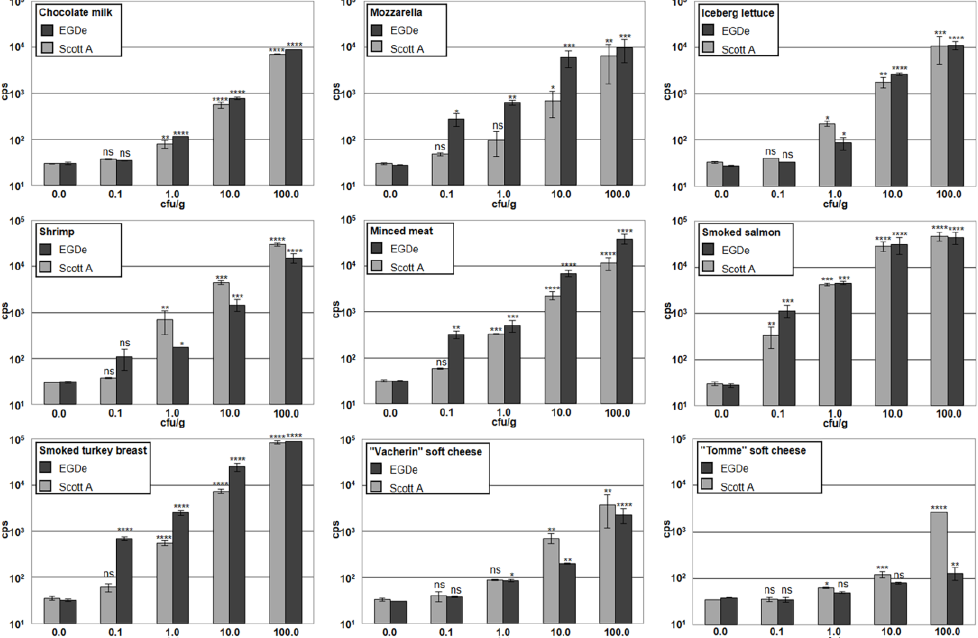
Figure 5. Detection of different concentrations of cells of L. monocytogenes ScottA and L. monocytogenes EGDe, in artificially contaminated food samples with the CBD-MS/A511:: luxAB assay. Eight samples for each food item were spiked with bacteria of either ScottA or EGDe strains, at contamination levels of 0.1, 1.0, 10.0, or 100.0 cfu/g. Additionally, one blank sample for each food item was prepared by adding sterile buffer without bacteria. All samples were tested for the presence of Listeria spp. in parallel. Error bars represent SD from two replicates. Asterisks indicate significant differences between values obtained from samples contaminated with bacteria and the respective blank samples. ****, p < 0.0001; ***, p < 0.001; **, p < 0.01; *, p < 0.05; ns, non-significant.